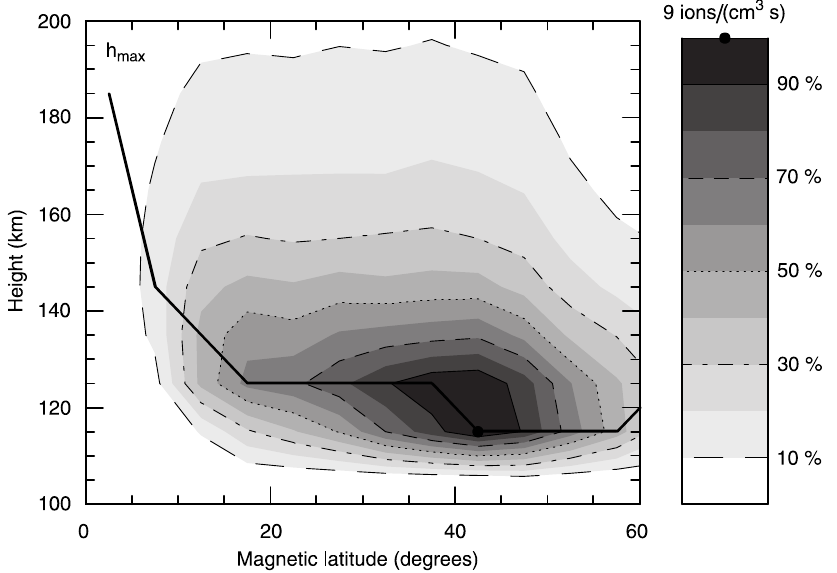
Fig. 5. Ionization production by neutralized ring current particles. The production rates are averages which refer to the first 4 hours of the simulation, excluding the initial 5 min which are dominated by the decay of loss cone particles. The maximum production rate is 9 ions/cm 3 s. The location of this maximum is indicated by a solid dot. The solid line h max indicates the height of the maximum ioniza- tion production as a function of magnetic